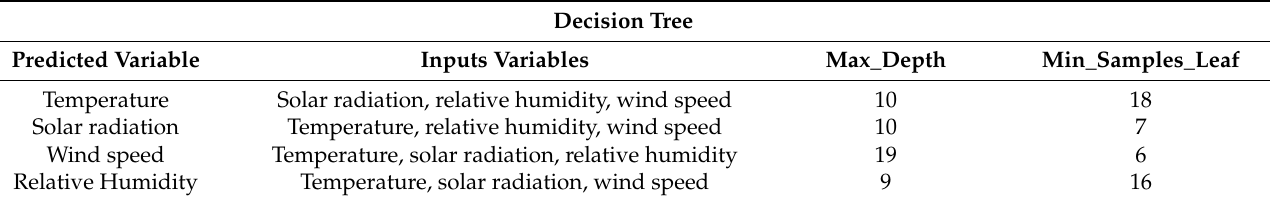
Table 3. Tuning parameters for the decision tree